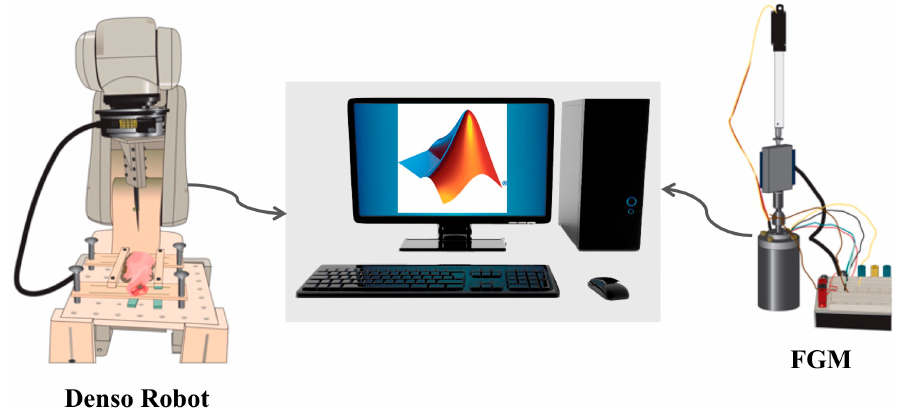
Figure 5. Experimental setup when connecting the FGM to the slave robot using a computer setting with MATLAB.